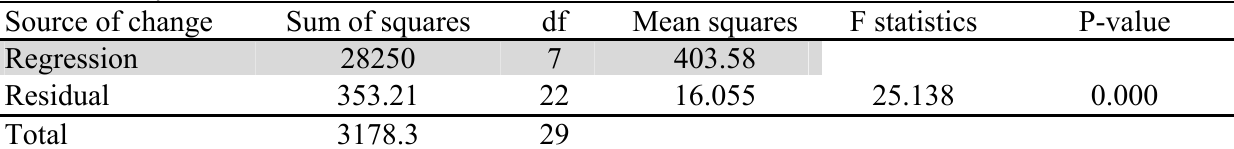
The summary of ANOVA